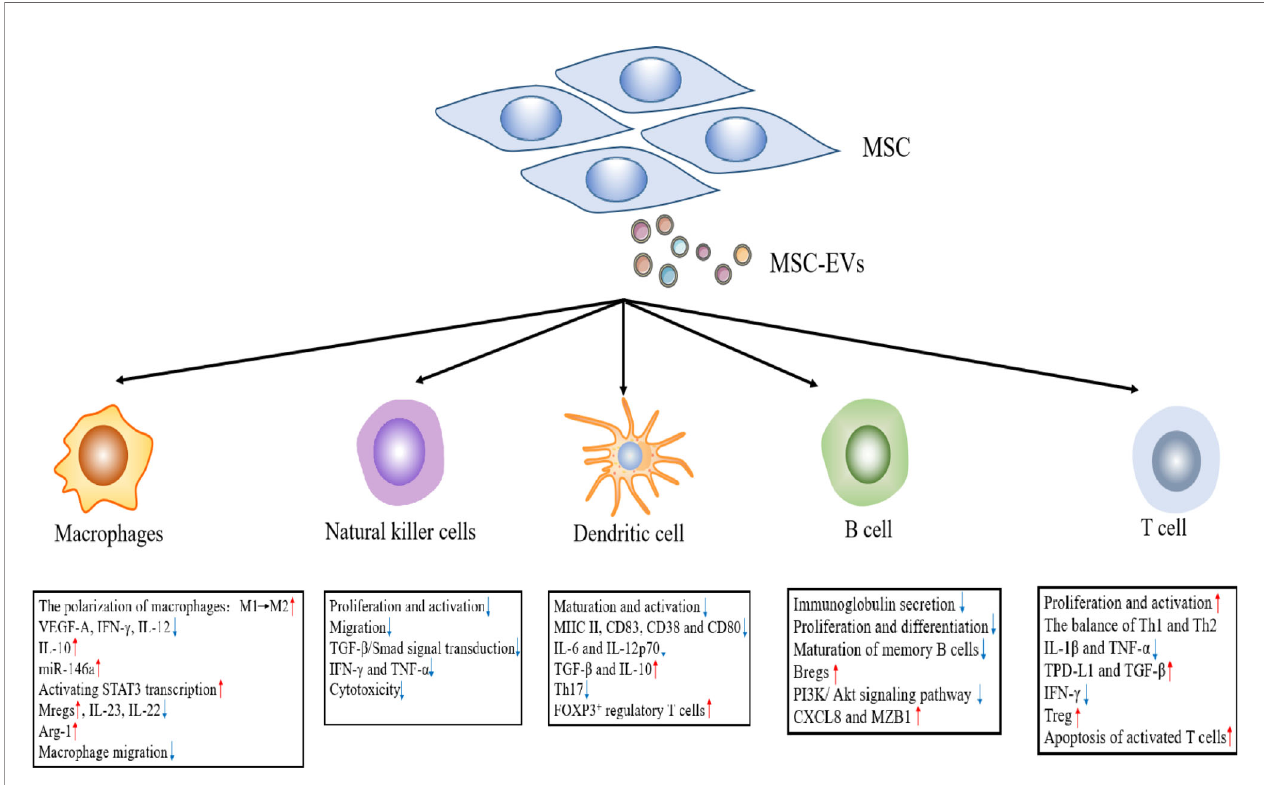
FIGURE 2 | The effects of MSC-EVs on immune effector